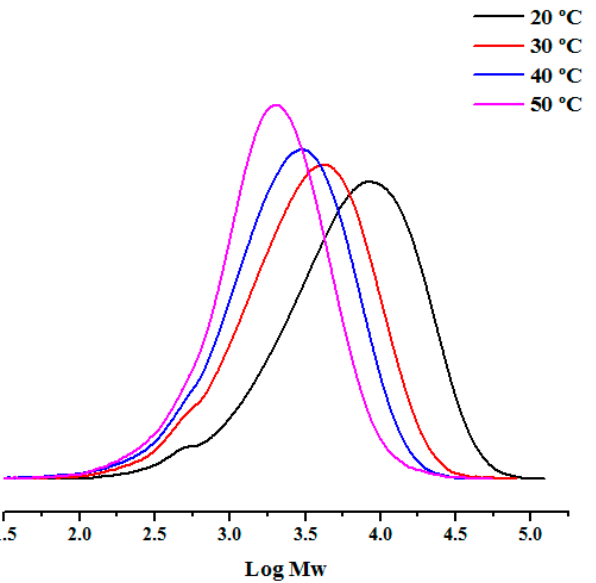
Figure 5. GPC curves of the PE produced using Ni1 /EtAlCl 2 at different reaction temperatures (runs 4, 7–9, Table 3).